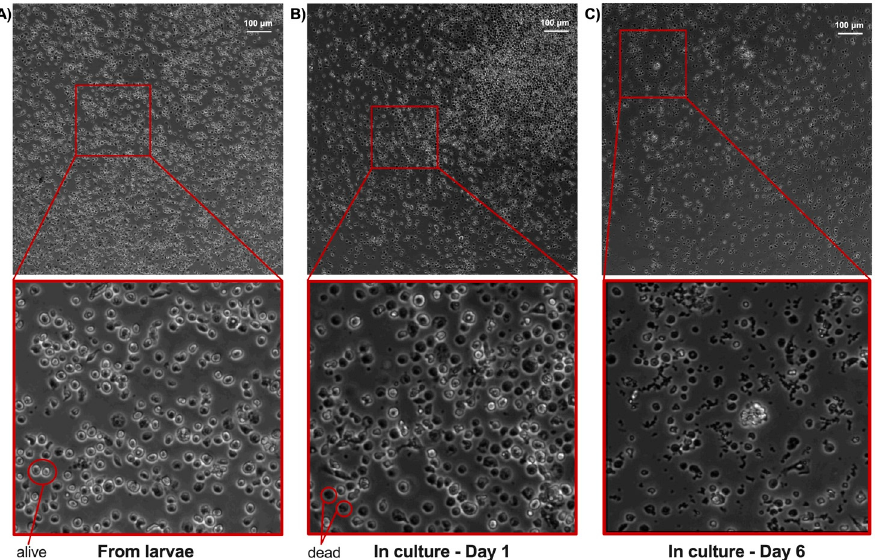
Figure 2. Evolution of the hemocyte primary cell culture. The red square indicates a magnification of the indicated image. Live cells appear refractive, whereas dead cells can be identified by their darker color (see arrows). ( A ) Hemocytes directly extracted and washed from the hemolymph of larvae. ( B ) Hemocytes in Grace medium on Day 1 of culture. ( C ) Hemocytes in Grace medium on Day 6 of culture. Substantial cell debris can be seen in the amplified images.